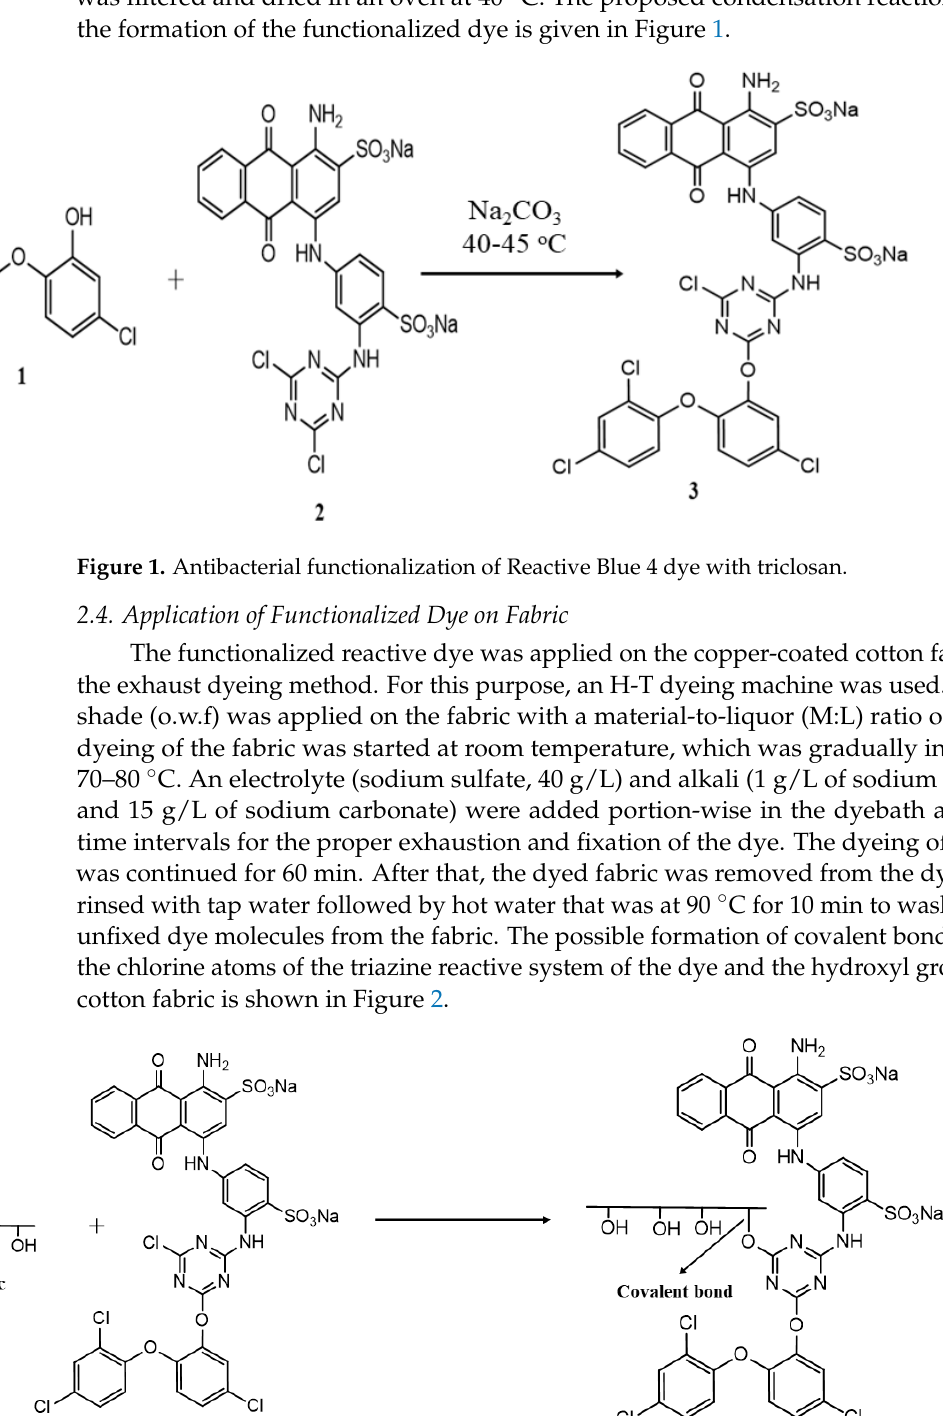
Table 2. Design of experiment for the developed samples.